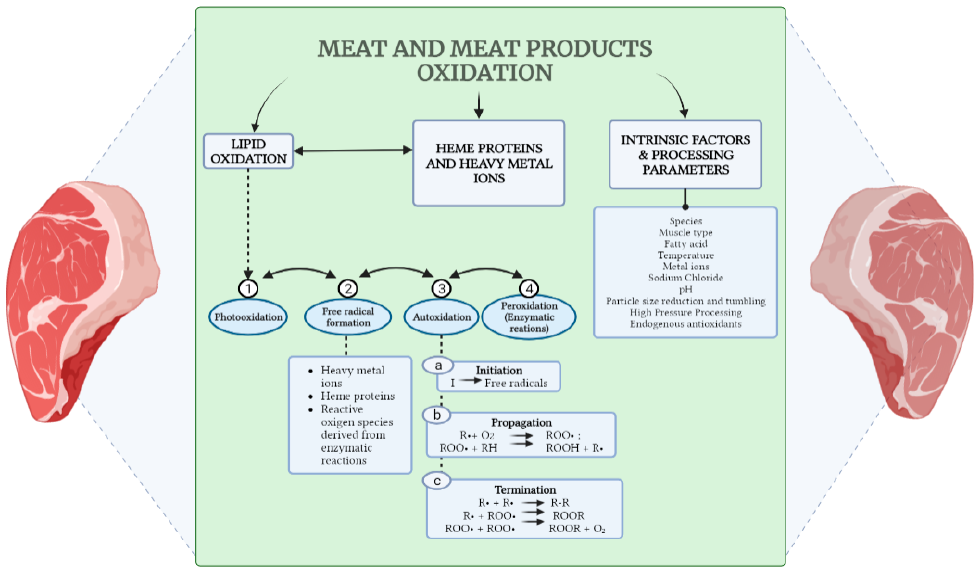
Figure 2. Meat and meat product oxidation in relation to lipid and myoglobin oxidation and other intrinsic and processing factors (illustration made via www.BioRender.com, accessed on 5 February 2023).